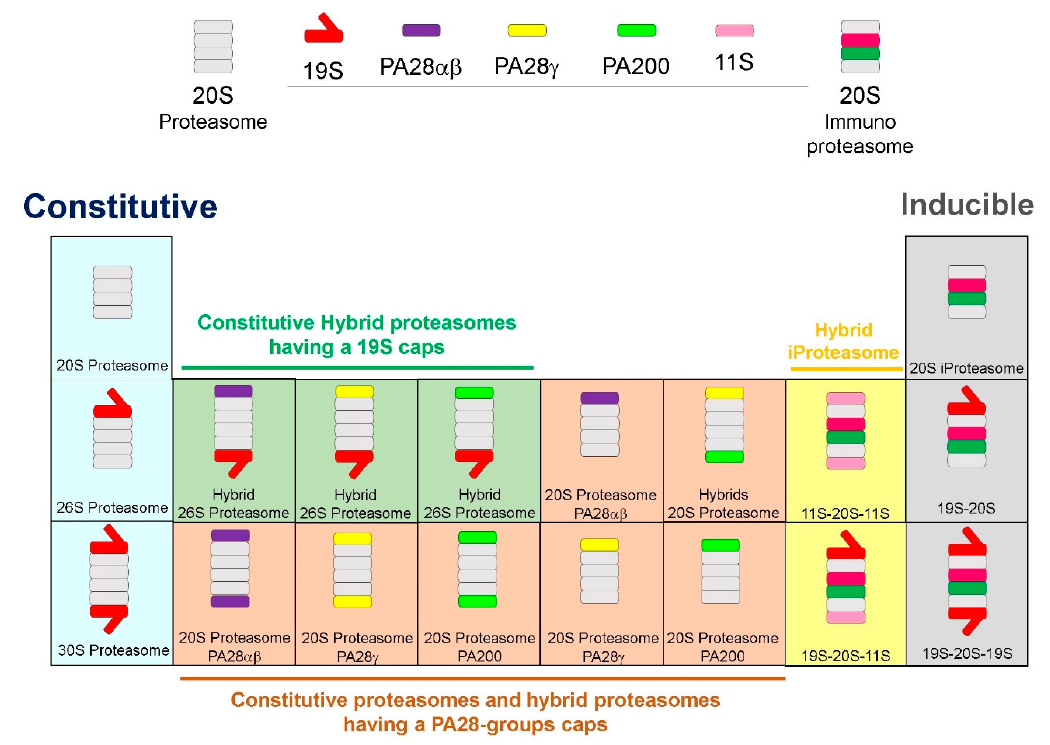
Figure 2. Types of Proteasomes. The constitutive proteasome is composed of the 20S CP and a single or double 19S cap to form the 26S or 30S proteasomes, respectively. When cells are exposed to inflammatory stimuli, i.e., TNF- α or IFN- γ , immunoproteasomes are assembled. The 20S CP incorporates β i-Ring, and is capped by PA28 α / β , PA28 γ , and PA200 caps on either one of both sides. Hybrid proteasomes have a 19S cap mixed with any of the activated caps (PA28 α / β , PA28 γ , and PA200). Hybrid iProteasome may be comprised of 11S, 20S, and 11S, or 19S cap, 20S, and 11S components. The inducible proteasome is composed of the 20S iProteasome and a single or double 19S cap to form the 19S-20S or 19S-20S-19S proteasomes,